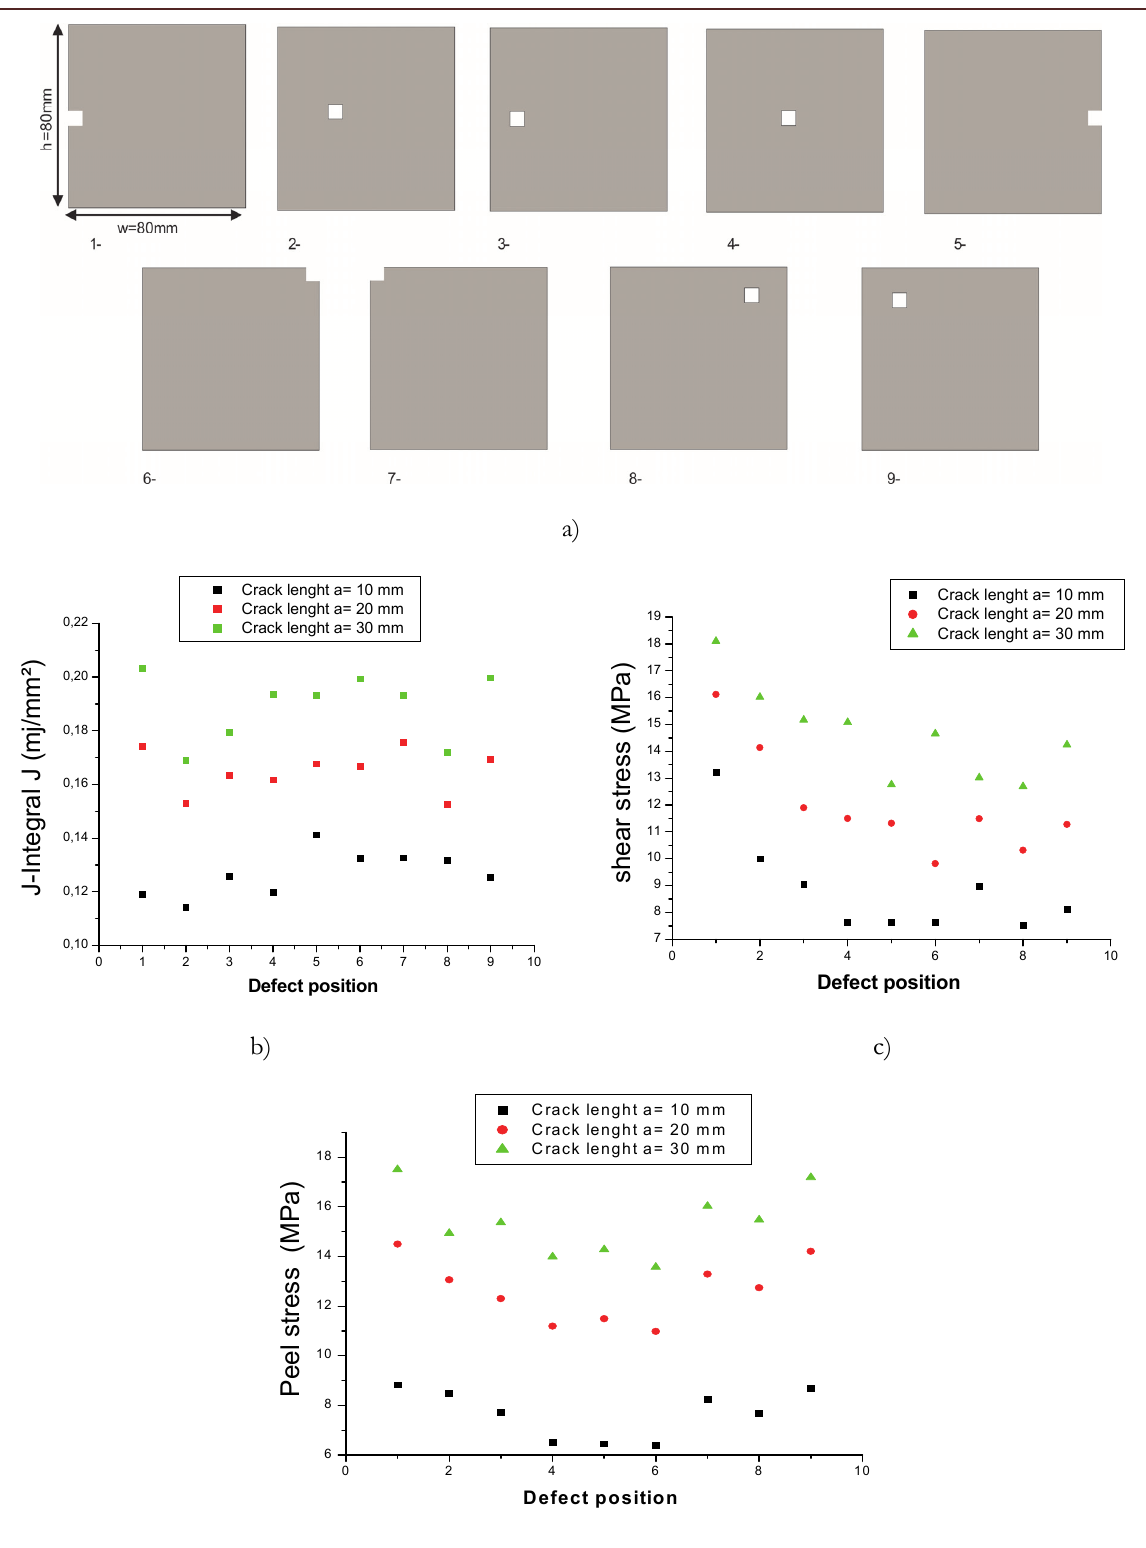
Figure 10 : a) Different position of default in the adhesive layer. b) Variation of the J-Integral in function of the position of the defect c) Variation of the Shear Stress as a function of the position of the defect. d) Variation of the Peel Stress according to the position of the